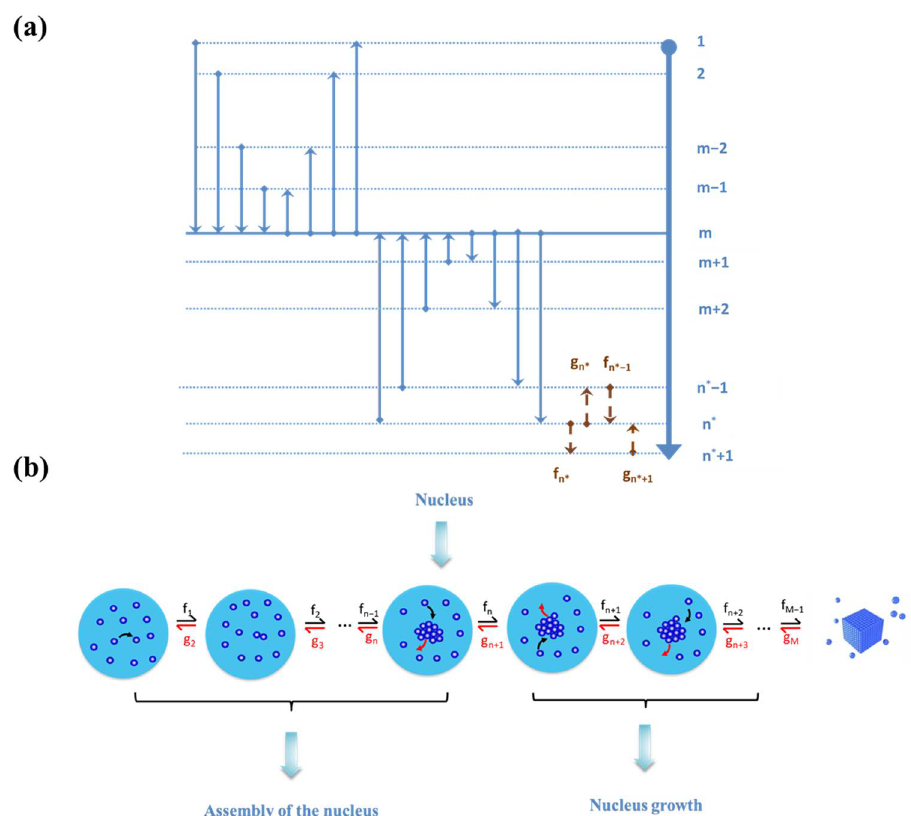
Figure 2. ( a ) Schematic illustration of all possible changes in the size of a cluster of m molecules (solid lines) and the change in the size of critical cluster n * by the attachment and detachment of monomers only according to the Szilard–Farkas model. ( b ) Evolution of clusters toward the formation of a critical nucleus in the framework of CNT, The black line and red line indicate the process of monomer attachment and desorption respectively. Reprinted/adapted with permission from [13]. Copyright 2017, copyright Davey, R.J.; Schroeder, S.L.M.; Ter Horst, J.H. et al. .